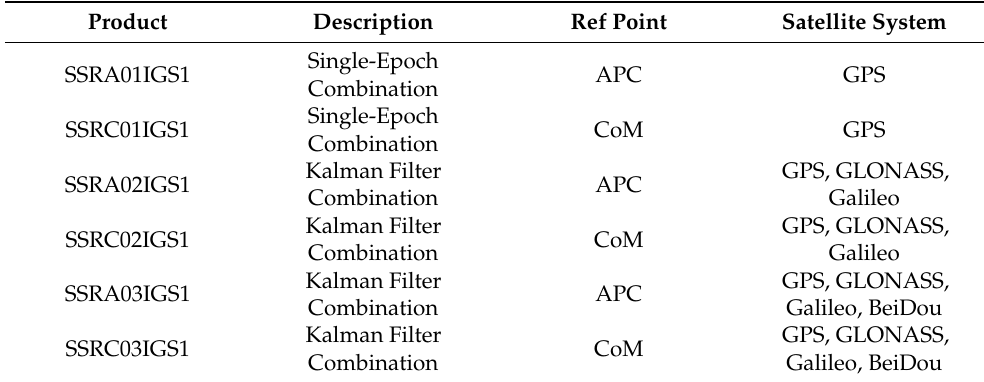
Table 1. List of RTS orbit and clock correction products.